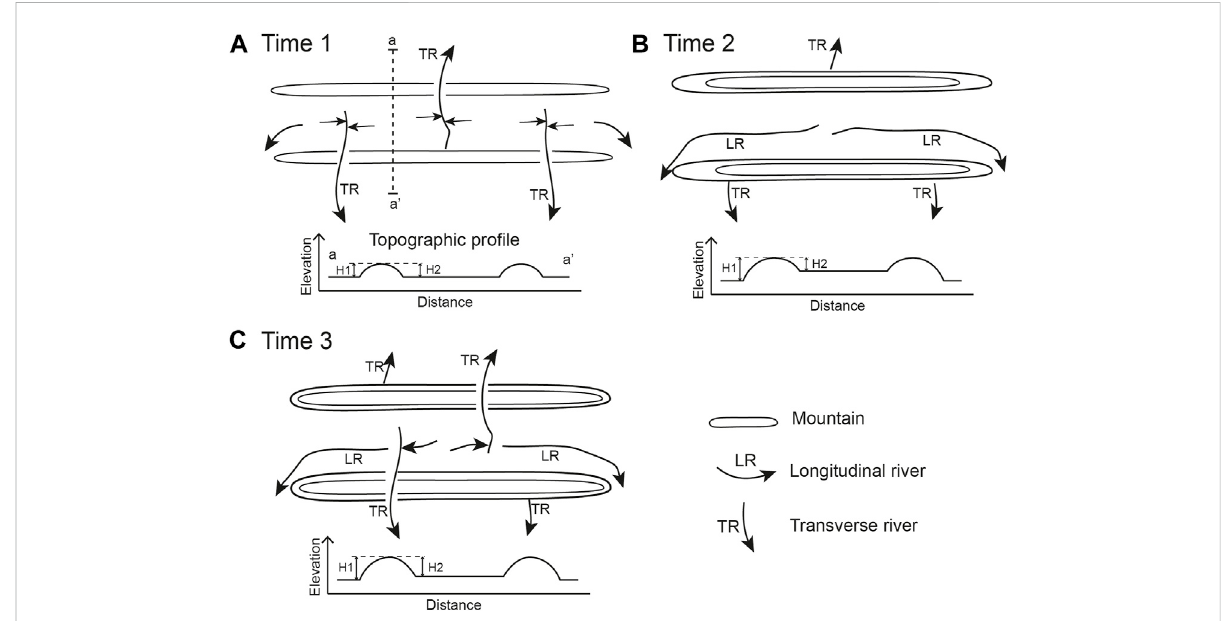
FIGURE 7 Idealized diagram of the model of drainage pattern evolution in active fold-thrust belts. Topographic pro fi les (a – a ’ ) show the elevation across the fold-thrust belt. (A) : At time 1, transverse rivers could cut through the structure. (B) : At time 2, transverse rivers would be defeated and diverted toward the fold tips. (C) : At time 3, transverse rivers could capture the upper longitudinal